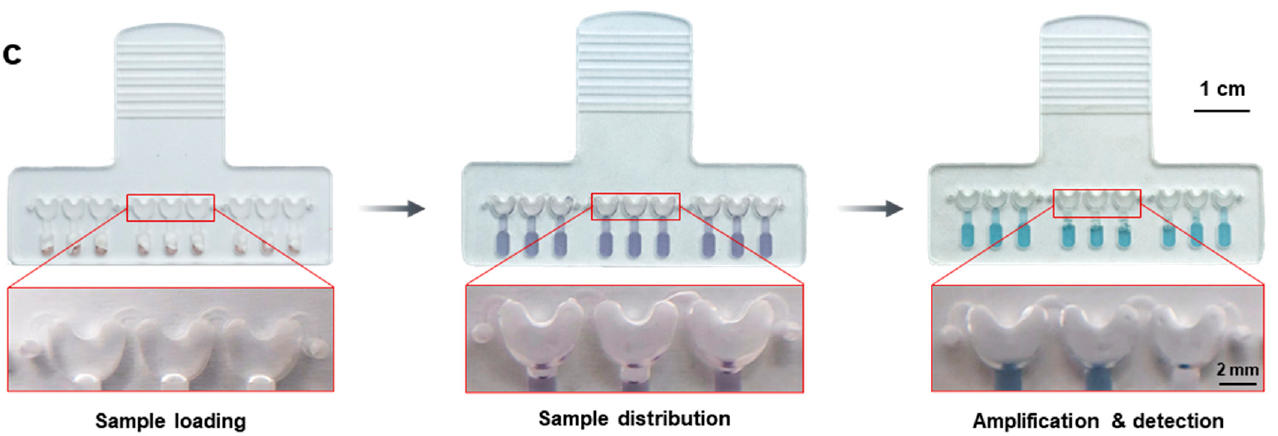
Figure 2. Optimization of the chip structure and characterization of the acceleration for liquid distribution. ( a ) Measurement of acceleration for liquid distribution in connected channels with various cross-sectional areas. The cut-off area (dark gray) indicates that acceleration in this region does not allow the liquid to be completely distributed. The probability area (light gray) indicates that the liquid in this acceleration region has the probability of being distributed. In the acceleration region above these two regions, the liquid could be fully distributed. ( b ) Maximum accelerations generated by four volunteers in several hand-swinging processes. Volunteers 1 and 3 were males, and volunteers 2 and 4 were females. ( c ) Liquid preservation in the chamber of the chip in different states.